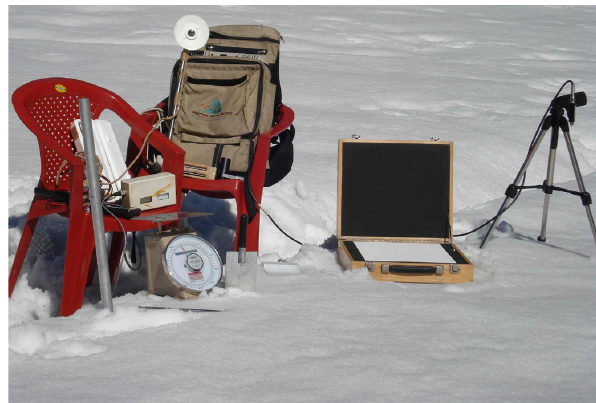
Fig. 2. Field experiment set-up of spectral reflectance measure- ments (winter